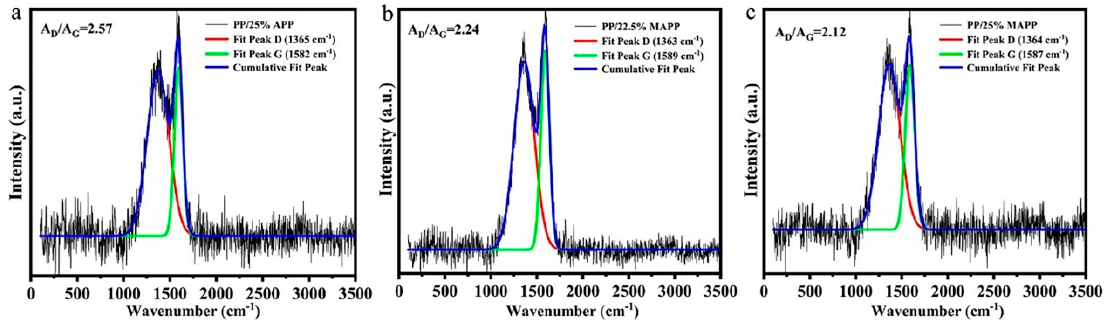
Figure 11. Raman spectra of char residues of ( a ) PP/25%APP, ( b ) PP/22.5%MAPP, ( c ) PP/25%MAPP after CCT.